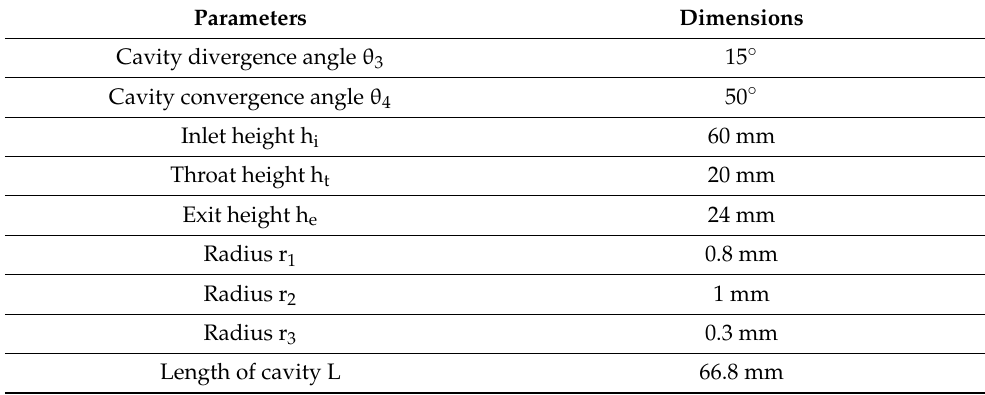
Table 1. The constant geometric dimensions and parameters adopted from Rui Gu [40].